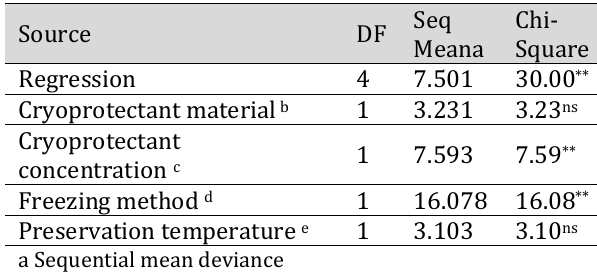
Table 1. Binary logistic regression analysis results for post-thawing revivability of preserved Vero cells under various preservation treatments.